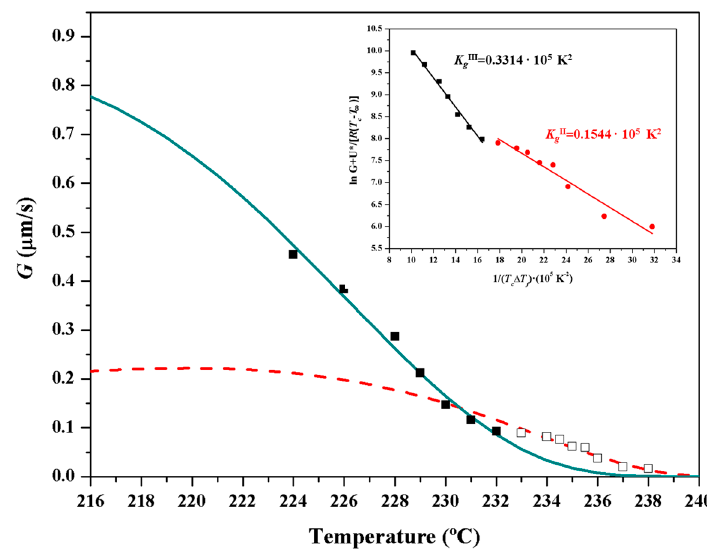
Figure 19. Temperature dependence of crystal growth rate (solid green line for Regime III and dashed red line for Regime II) determined by Lauritzen–Hoffman equation and using the best fit parameters deduced for the two crystallization regimes. Experimental crystal growth rates and indicated by the square symbols. The inset shows the plot of ln G + U */ R ( T c − T ∞ ) versus 1/ Tc ( Δ T ) f to determine the Kg secondary nucleation parameters.